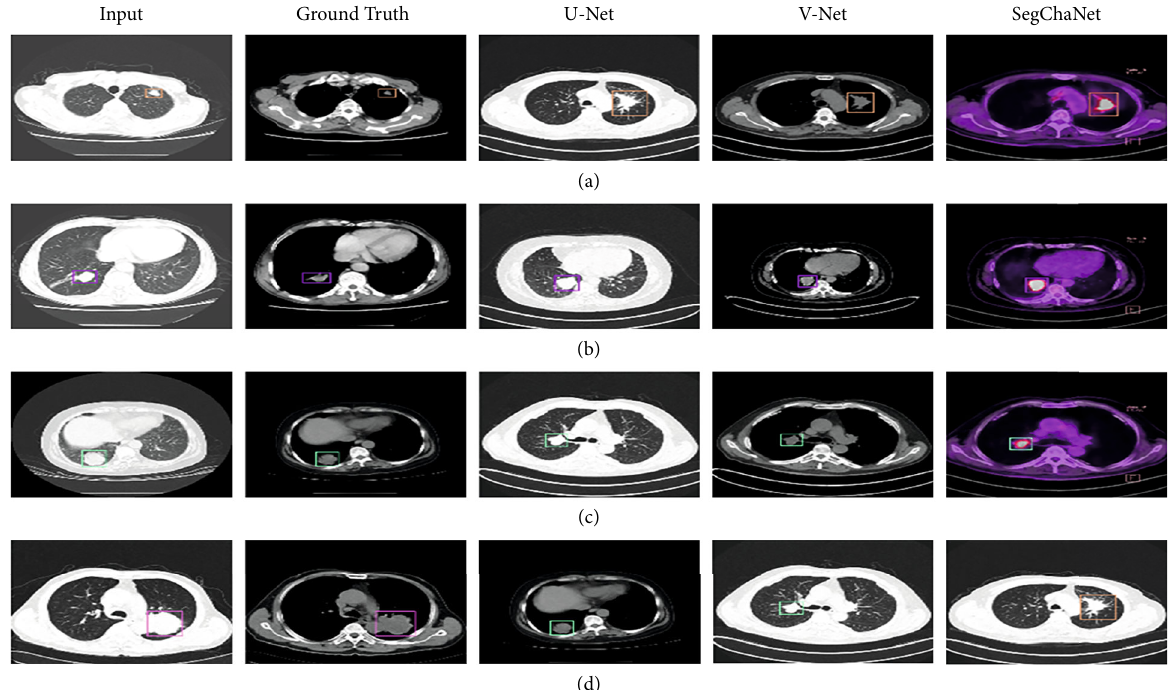
Figure 7: Marked images using grad cam.